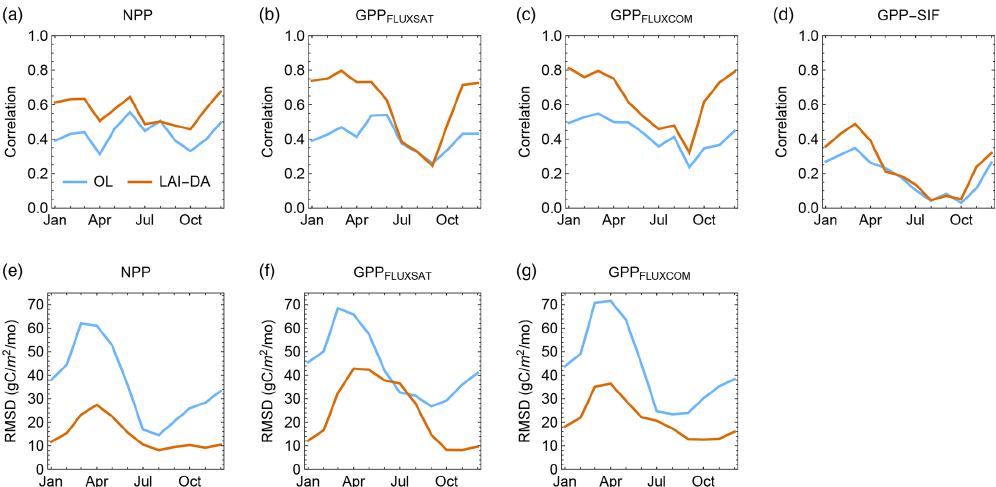
Figure 6. Metrics for the OL and LAI-DA simulated net primary production (NPP) and gross primary production (GPP) against reference data sets averaged over the sum of open shrublands, croplands, and grasslands. Shown are the (a) correlation and (e) RMSD for NPP evaluated against FAO WaPOR NPP data set for the period of 2009–2019, the correlation (b, c) and (f, g) RMSD for GPP evaluating against FLUXSAT GPP product for the period of 2003–2019 and FLUXCOM GPP product for the period of 2003–2015, and the (d) correlation between the simulated GPP and GOME-2 Sun-induced chlorophyll fluorescence (SIF) for the period February 2007 to February 2019.